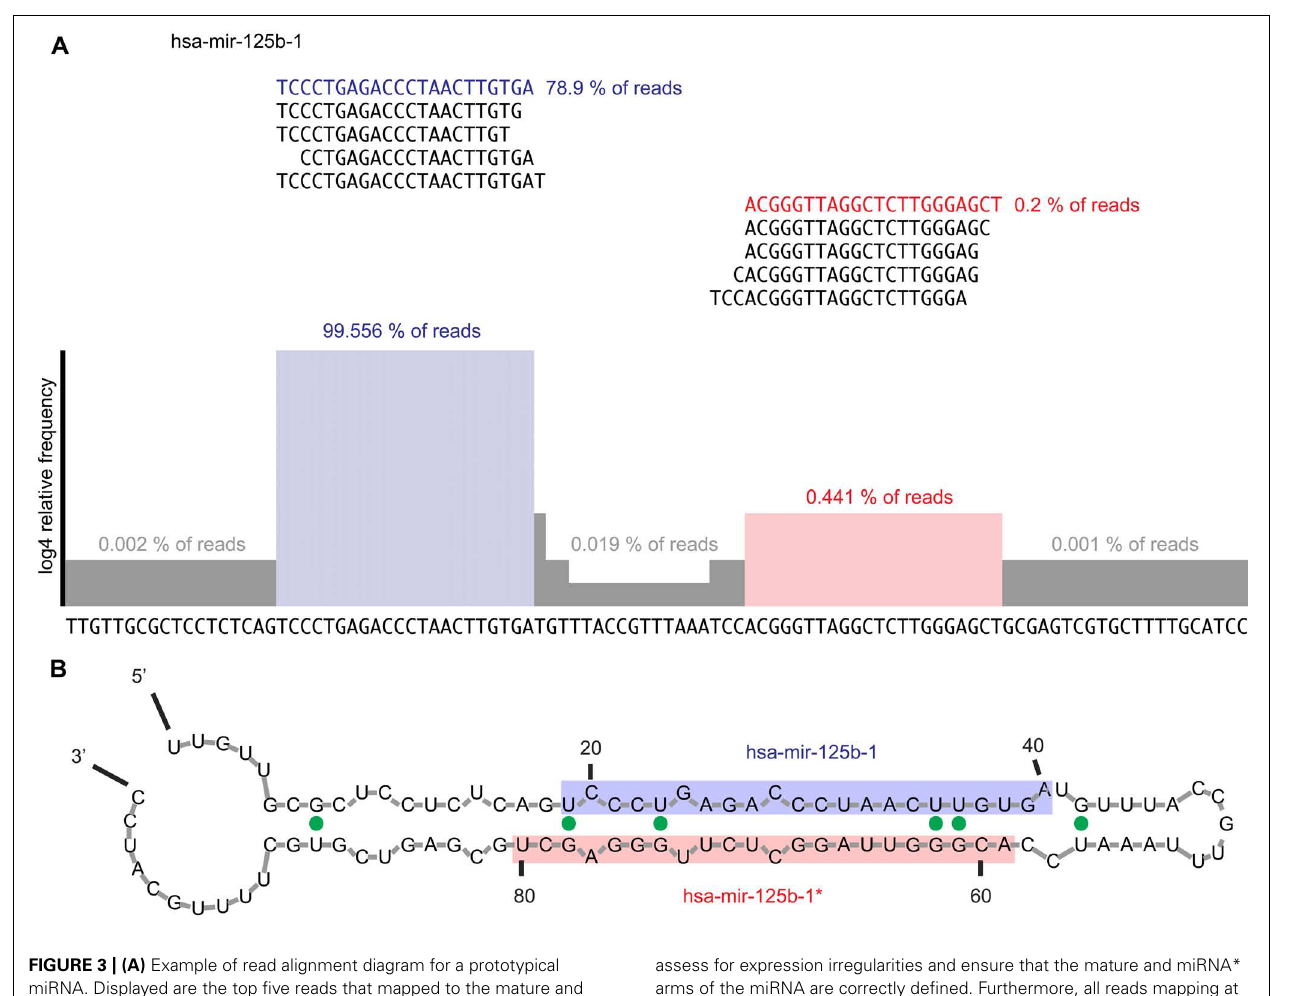
assess for expression irregularities and ensure that the mature and miRNA* arms of the miRNA are correctly defined. Furthermore, all reads mapping at each error distance would be displayed. (B) Example of secondary structure prediction for mir-125b-1 precursor RNA. Mfold (Zuker, 2003) was used to generate a secondary structure prediction for each miRNA to confirm the foldback and overhang structure expected from a prototypical miRNA.The mature sequence is shaded blue, while the miRNA* sequence is shaded in red.The expected stem-loop structure and 2-nt 3 (cid:2) overhang is observed. G–U wobbles are indicated by solid green